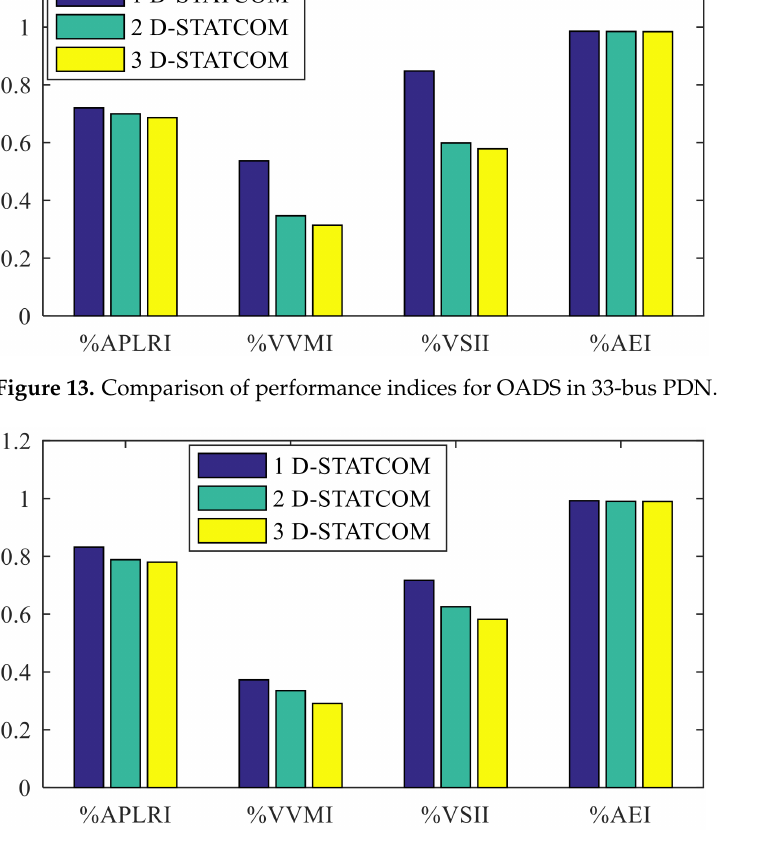
Figure 14. Comparison of performance indices for OADS in 51-bus PDN.